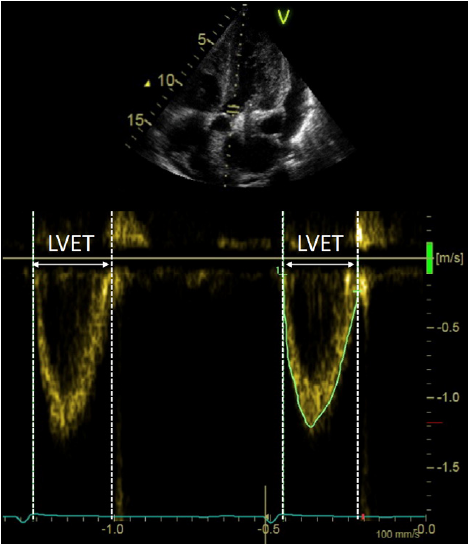
Figure 1. Left ventricular outflow tract velocity profile showing measurement of left ventricular ejection time (LVET).